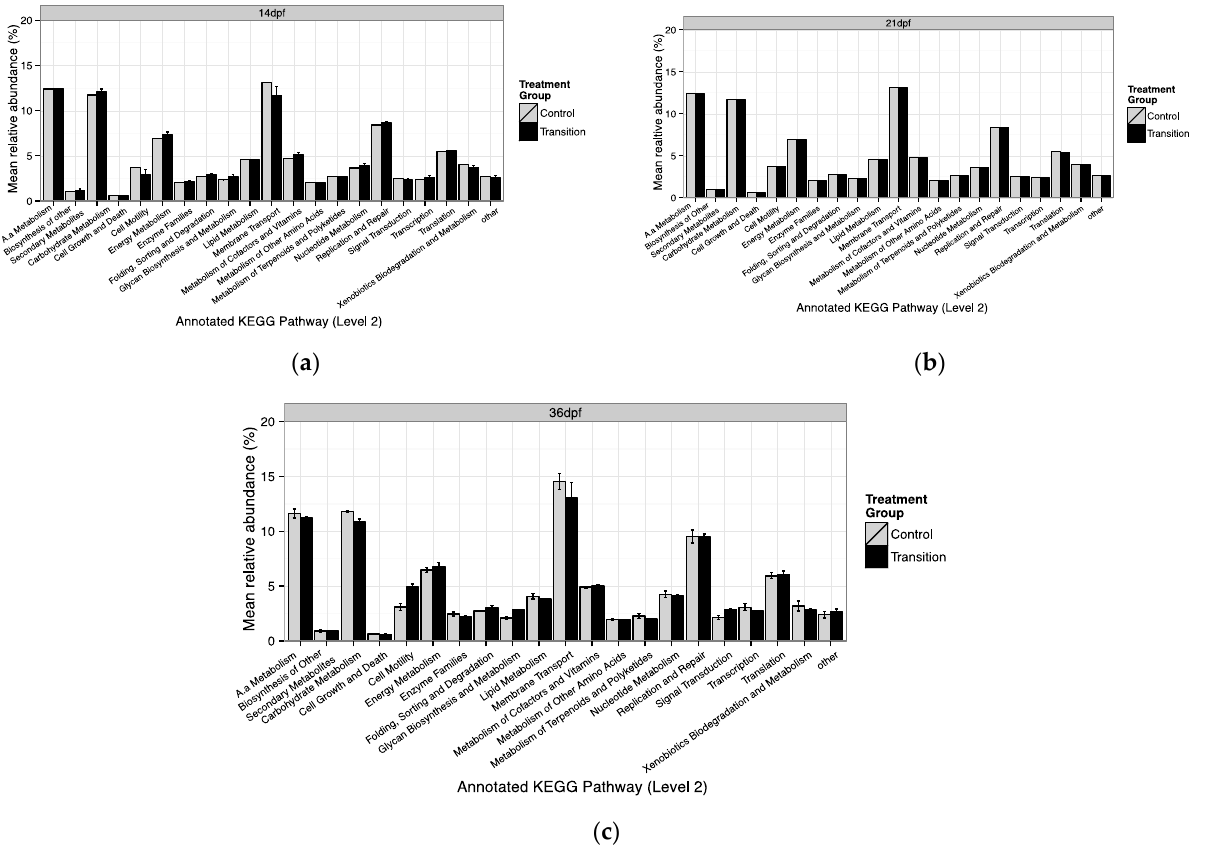
Figure 6. Relative abundance of the 20 most prevalent annotated functional groups identified using KEGG orthologs pathway categorized at molecular-level 2 associated with lake sturgeon larval GI tract microbiome associated with two food treatments (control (CR) and transition (TR)) at each sampling point ( a ) 14 dpf; ( b ) 21 dpf; and ( c ) 36 dpf. We observed the higher SDI values in proteolytic bacterial isolates present in larvae from the TR compared to the CR treatment (0.533 in TR vs. 0.165 in CR). While no specific grouping for the Aeromonas bacteria was observed between the two experimental groups, there was an unequal distribution of the Pseudomonas bacteria between larvae from the CR and TR groups. In particular, three clades that were identified belong to bacteria isolated from the fish with the transitional bloodworm diet. Unique isolates for the TR group clustered in these clades ( Pseudomonas fluroscens , P. putida , P. protegens , and P. rhodesiae ), and were marked with asterisks (Figure 7). Only one clade associated with CR was found to contain a unique cluster of Pseudomonas jessenii . Two Aeromonas species were found to be present only in TR treatment individuals ( A. salmonicida ) and CR ( A. hydrophila ) fish, respectively, yet both clustered in the same